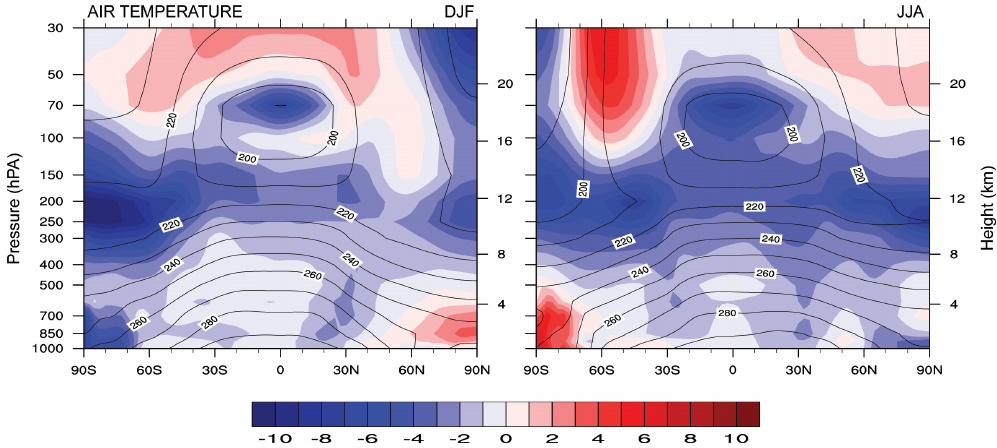
Fig. 9. Zonally averaged air temperature (K) climatology from NorESM for 1976–2005 (black contours) and differences from the NCEP (1976–2005) climatology (Kalnay et al., 1996) (colour). Left and right panel is for boreal winter (DJF) and summer season (JJA), respectively.